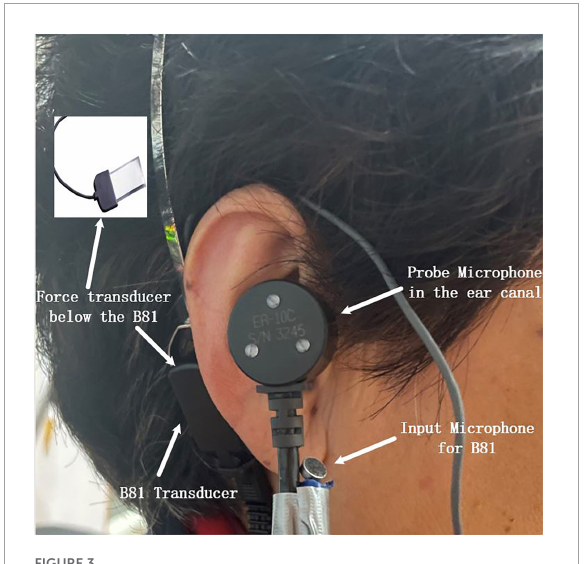
FIGURE3 The master bone conduction (BC) hearing aid was connected to a subject during the aided response measurements. The input microphone and B81 transducer were the input and the output of the master BC hearing aid, respectively. The probe microphone in the ear canal was used for the SPL measurements, and the force transducer under the B81 transducer (tightly between the B81 transducer and the mastoid) was used for the FL_FT measurements. The small picture in the upper left corner shows the piezoelectric thin-film force